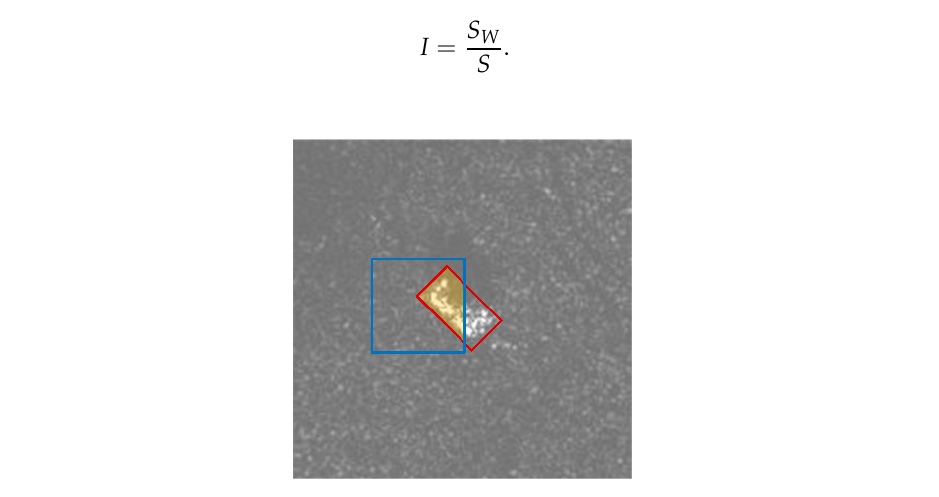
Figure 8. Description of overlap degree weighted pooling.